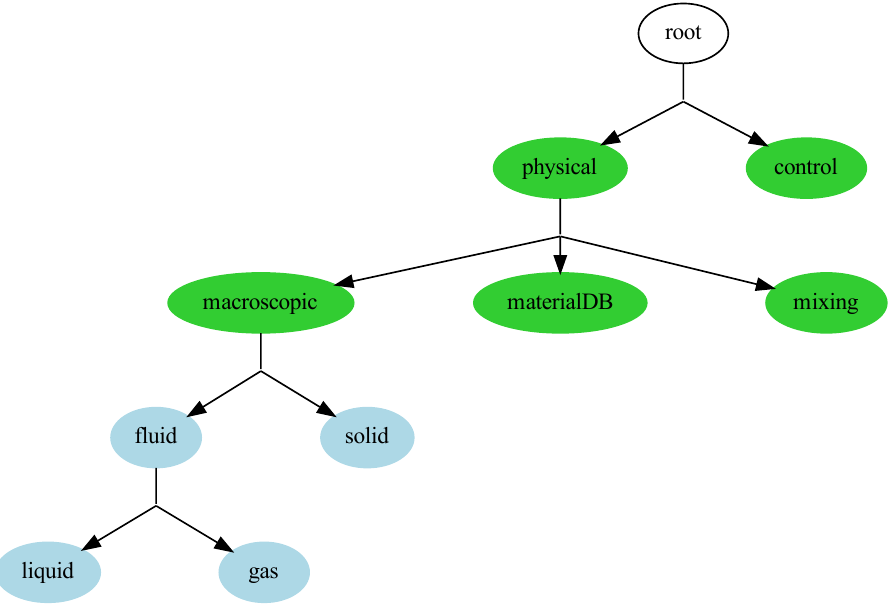
Figure 4. A sample discipline tree. It is designed to capture a very wide range of processing plant models. The green nodes are in an inter-relation, and thus transfer tokens, while the blue ones are in an intra-relation, and thus transfer state